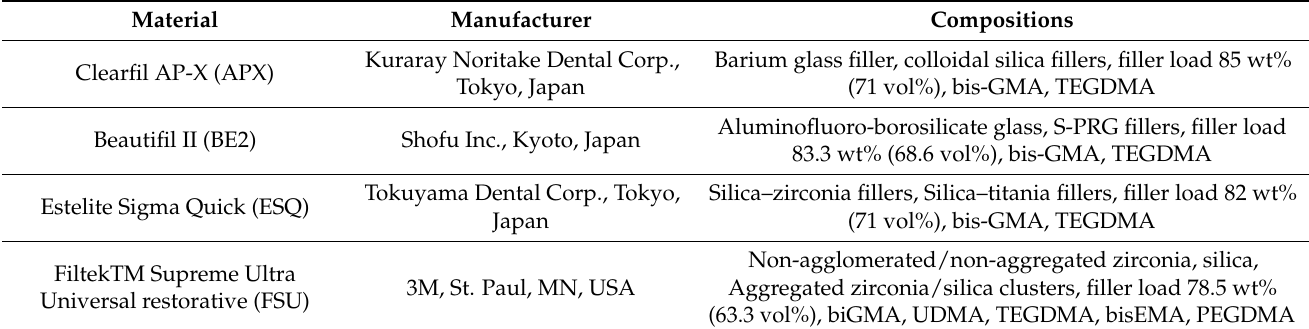
Table 1. Compositions of the four resin composites used in this study.